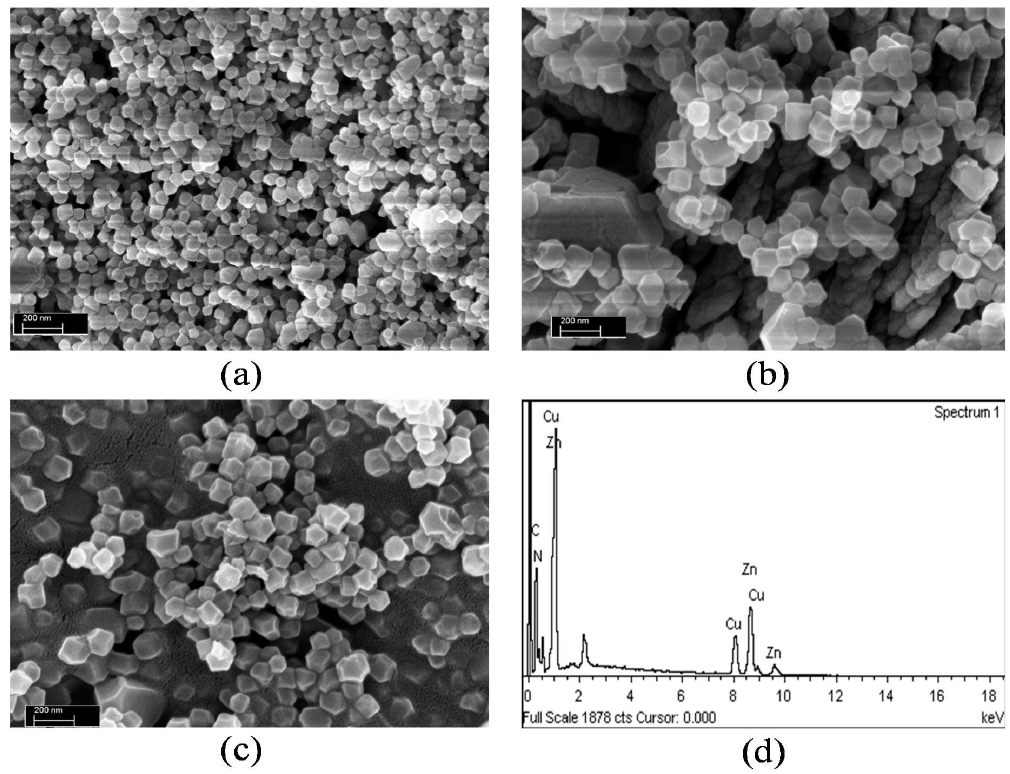
Figure 5. FESEM images of ( a ) 1Cu/ZIF-8N2 ( b ) 2Cu/ZIF-8N2 ( c ) 3Cu/ZIF-8N2 and ( d ) EDX image of 2Cu/ZIF-8N2.